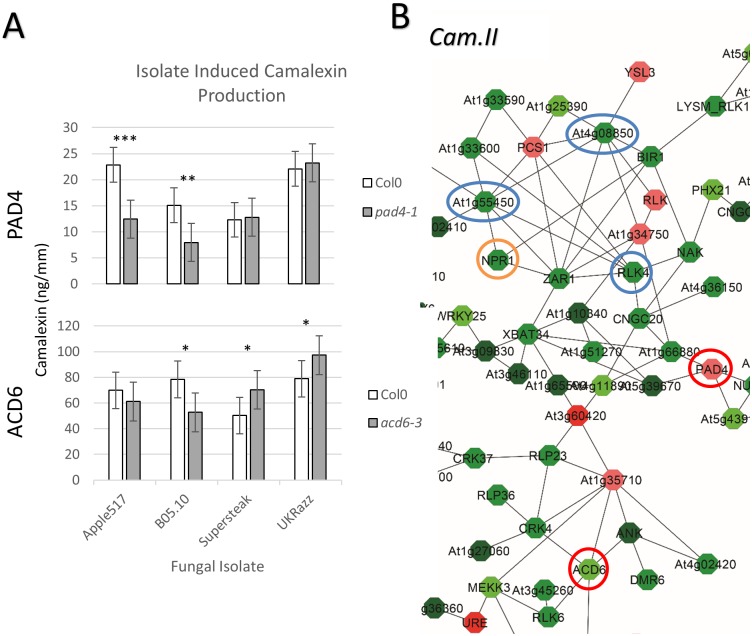
Camalexin validation and network.(A) Bargraphs showing the model corrected means for induced camalexin production of all four isolates on wildtype Col-0 versus pad4-1 and acd6-3 mutants. Significance of the difference in camalexin accumulation between Col-0 and the pad4-1 mutant with each isolate are shown as P< 0.001 ‘***’, 0.001 ‘**’ and 0.01 ‘*’. (B) Magnified images of the Cam.II co-expression network with visible gene names are shown with genes highlighted in the text circled. Single gene knockouts are circled in red while known major defense hormone receptor genes are circled in orange and major hubs are circled in blue.